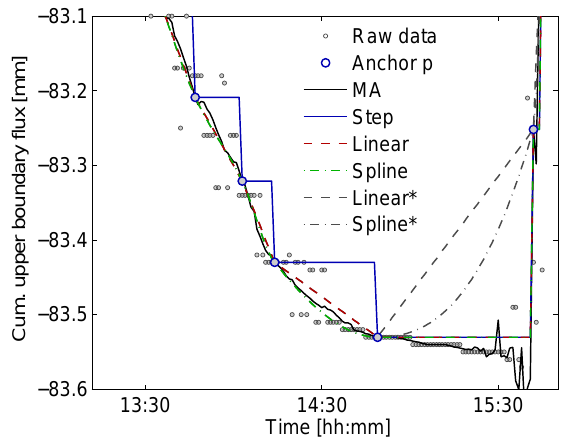
Figure 6. Raw data of a period of evapotranspiration followed by a precipitation event on 7 July 2014. Anchor p: anchor point; MA: moving average; steps: original step interpolation scheme; linear: linear interpolation scheme; spline: cubic Hermitian spline inter- polation scheme; linear ∗ : linear interpolation scheme without pre- cipitation correction; spline ∗ : cubic Hermitian spline interpolation scheme without precipitation